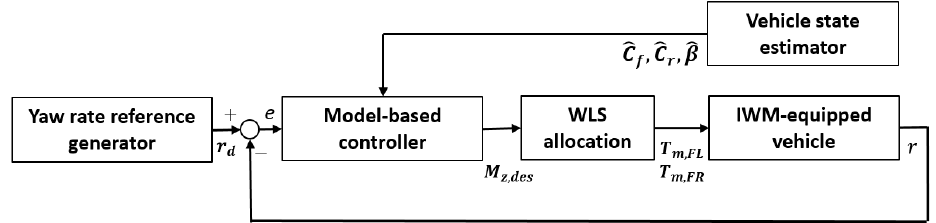
Figure 3. Block diagram of the overall control algorithm.